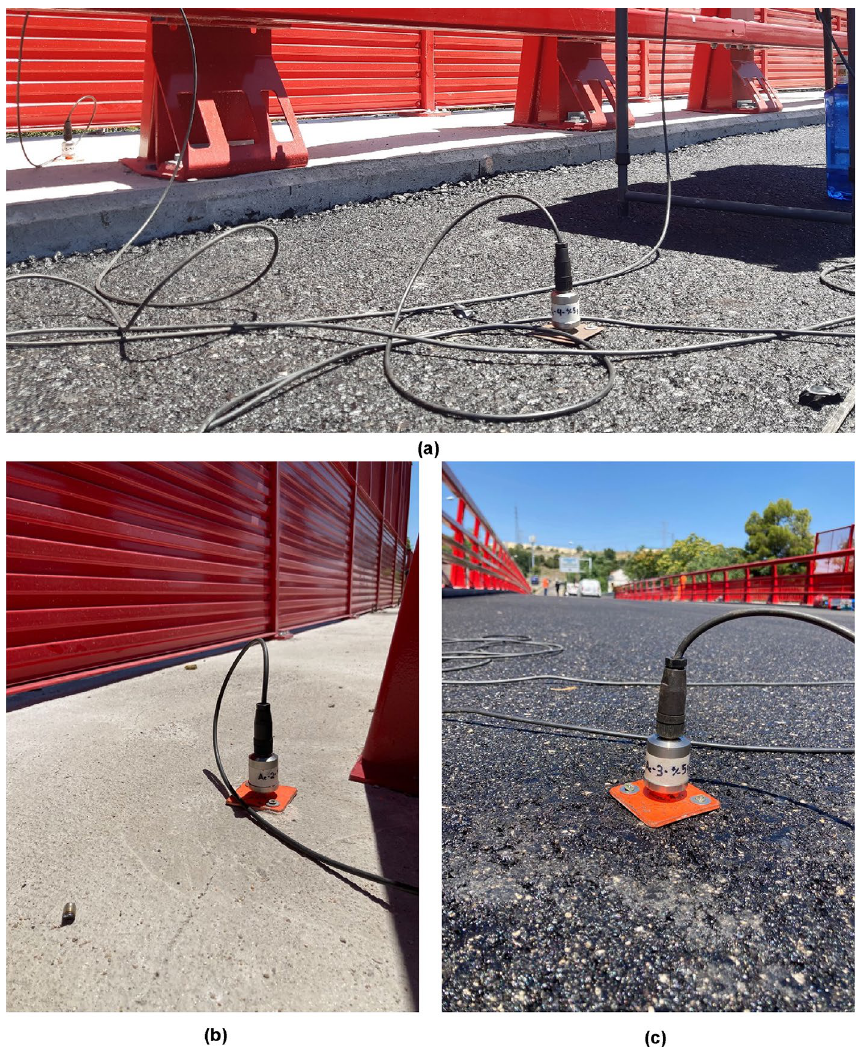
Figure 11. Piezoelectric accelerometers used in road bridge dynamic load test: ( a ) piezoelectric accelerometers on girders 1 and 2; ( b ) piezoelectric accelerometer on girder 8; ( c ) piezoelectric accelerometer on girder